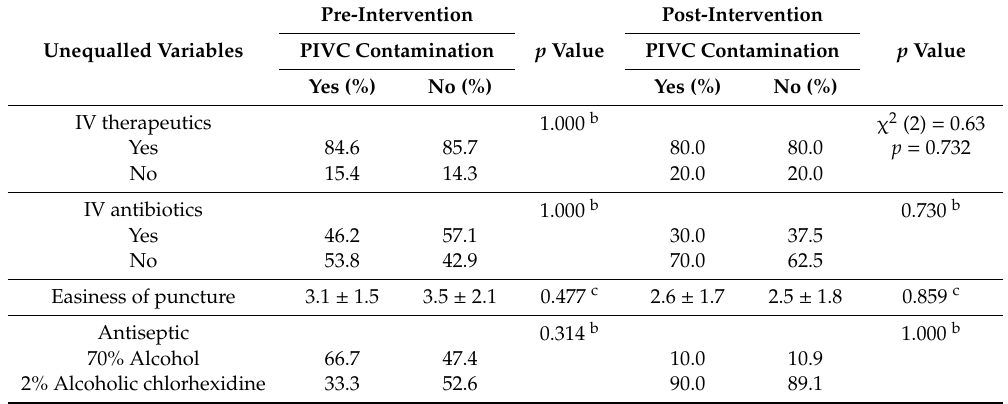
Table 4. Relationship between unequaled variables and PIVC contamination for both study groups.